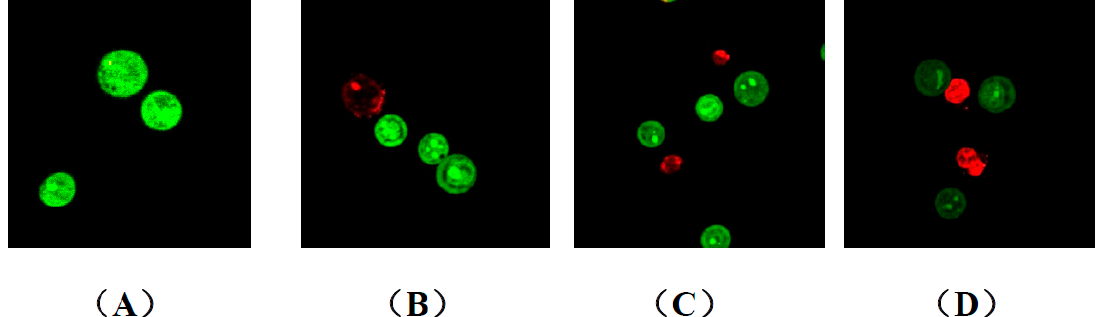
Figure 8. Morphological observation of 2i with AO / EB double staining under fluorescence microscope (630 × ) on HL-60 cells. ( A ) Cells not treated with 2i (control); ( B ) cells treated with compound 2i at 6.25 µ M; ( C ) cells treated with compound 2i at 12.5 µ M; ( D ) cells treated with compound 2i at 25 µ M.